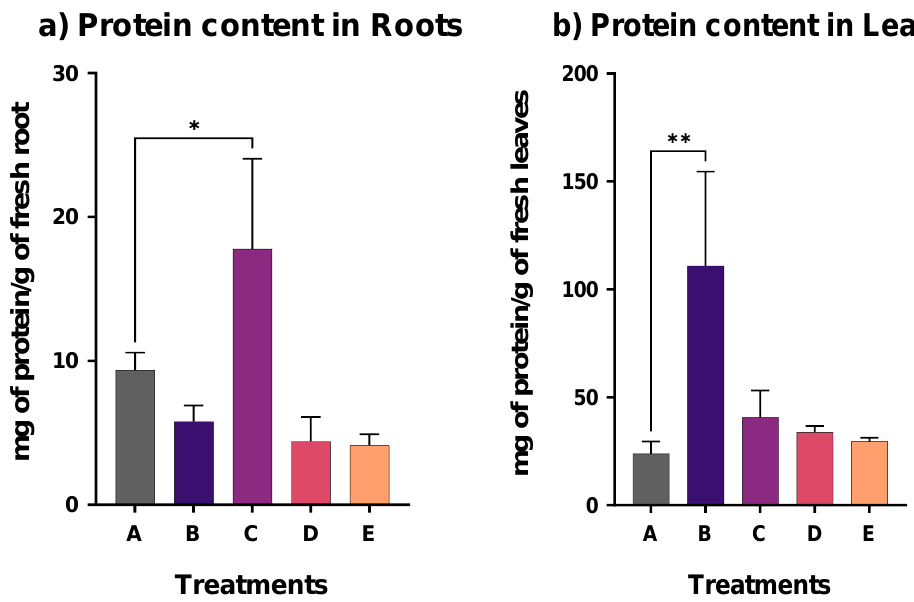
Figure 1. Protein content (mg protein/g FW) in ( a ) root and ( b ) leaves for all treatments (star indicates the level of significance: * for p < 0.05, ** for p < 0.01).